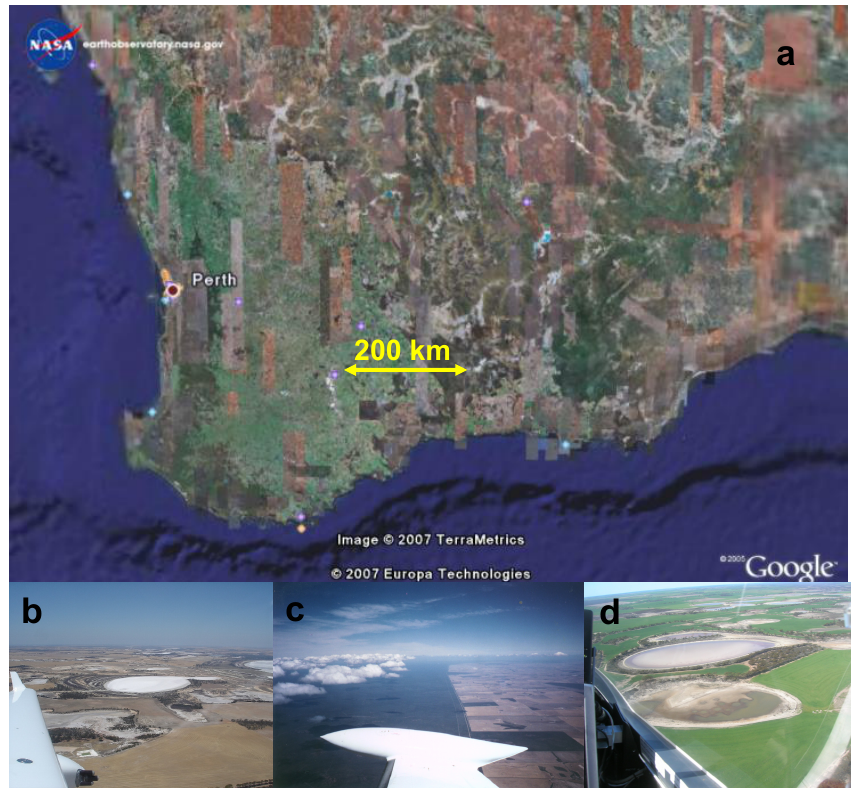
Fig. 1. Western Australia seen from the satellite (a) , summer (b) and winter (d) surface conditions in the agricultural region and the State Barrier Fence area (c) , in yellow the location of the flight experiments. The circular ponds (b, d) are salt lakes, bright white in summer, different colours in